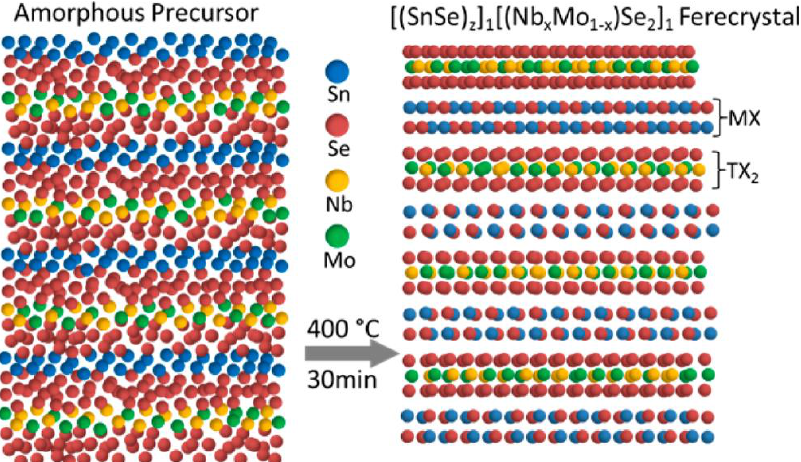
Figure 9. Schematic drawing of the synthesis of (SnSe) 1.09 − 1.16 Nb x Mo 1 − x Se 2 alloy ferecrystals. On the left is the as-deposited amorphous precursor. On the right is the ferecrystal alloy after annealing (400 ◦ C) and self-assembly (adopted with permission of the ACS from